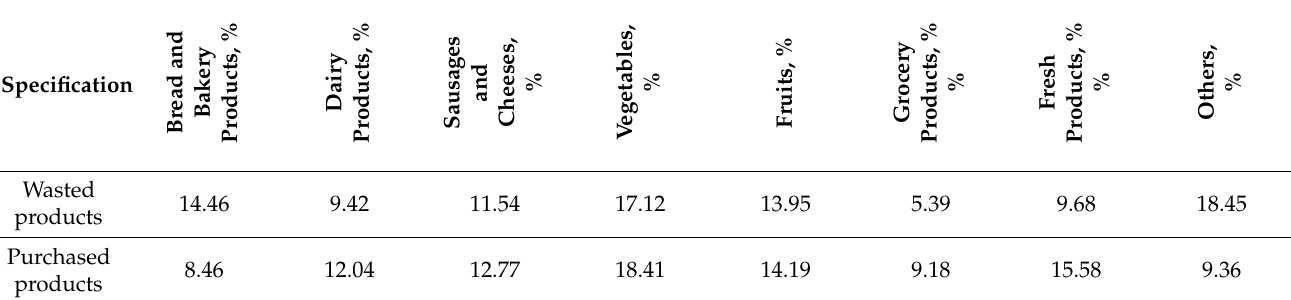
Table 6. Percentage of products purchased and discarded, by category.